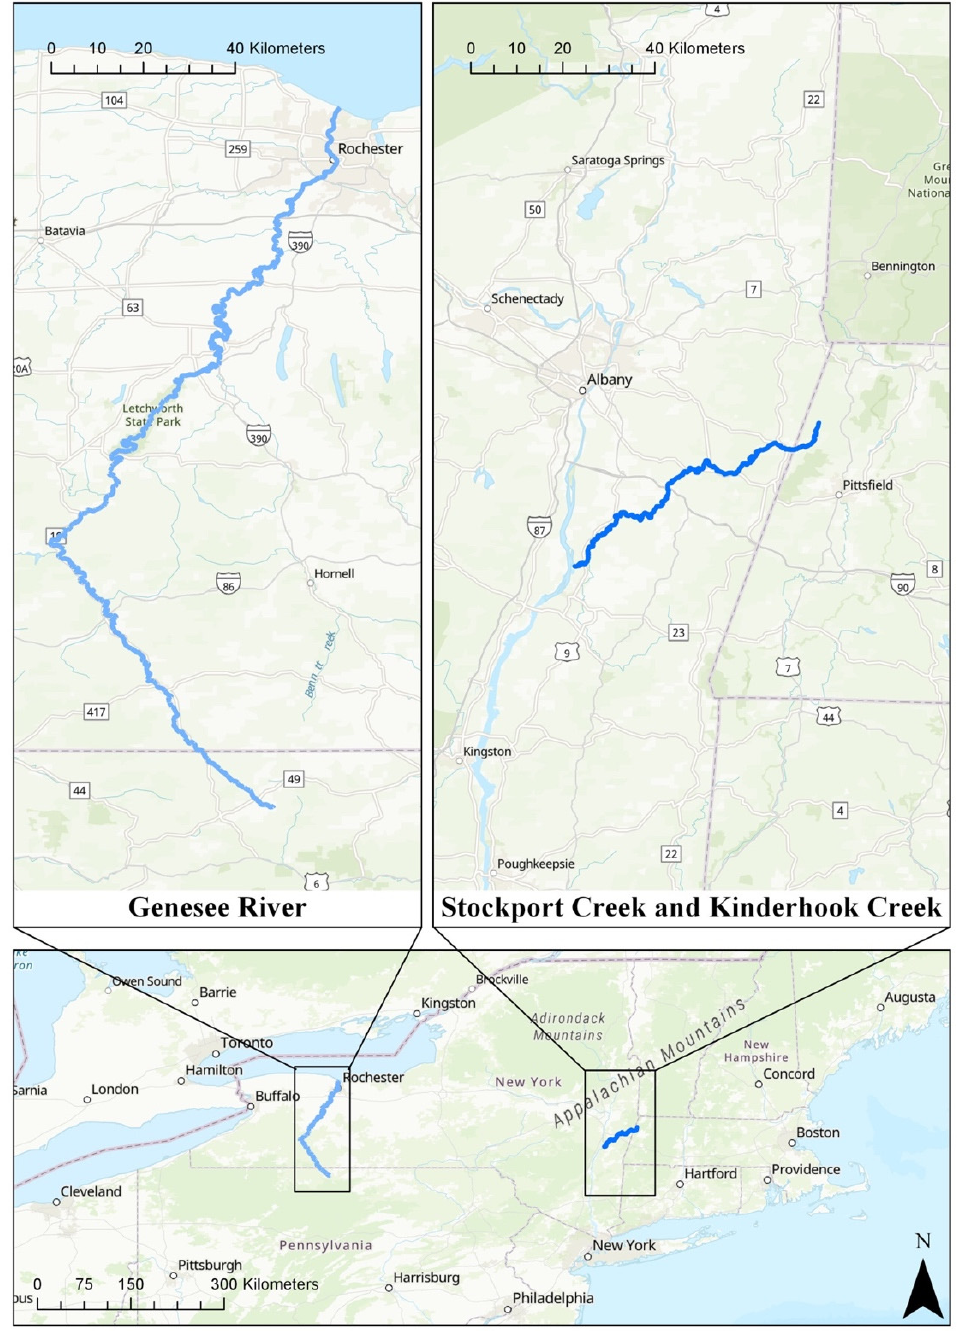
Figure 1. Map of studied streams in western (Genesee River) and eastern (Stockport and Kinderhook Creeks) New York State, US. Basemap is World Topographic Map.